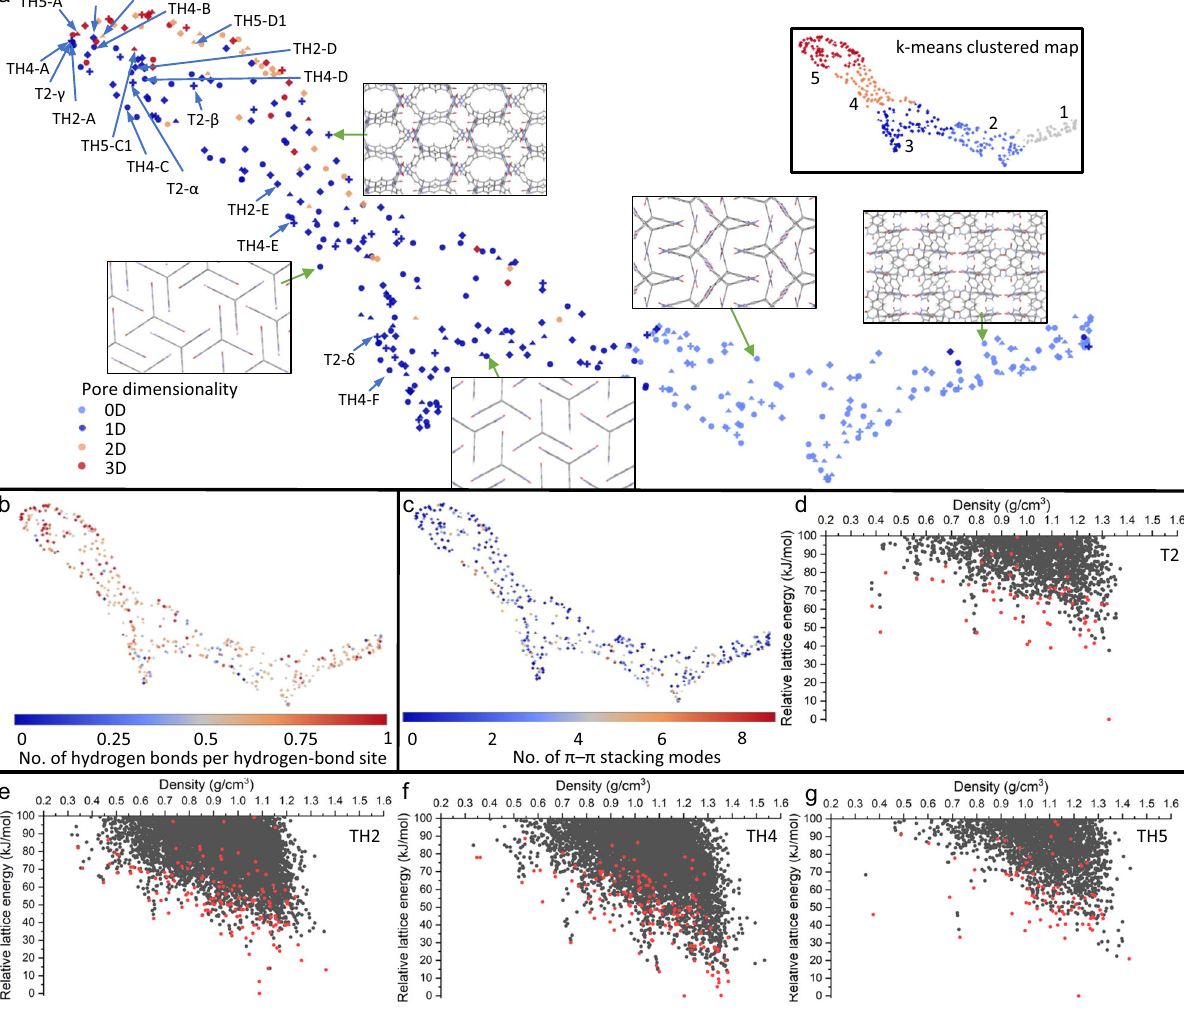
Fig. 5 Porosity space of the landmark structures of TH2, TH4, TH5 and T2. a – c 2D UMAP embeddings of the porosity spaces of TH2 (diamond), TH4 (circle), TH5 (triangle) and T2 (cross), colour coded by the pore dimensionality ( a ), the number (no.) of hydrogen bonds per hydrogen-bond site ( b ), or the total number of π – π stacking modes of the crystal structure ( c ); the symbol size is scaled by the accessible surface area. All the points shown in ( a – c ) are the lowest-energy structures in the respective clusters by af fi nity propagation and are highlighted in red on their corresponding energy – density landscapes: T2 ( d ), TH2 ( e ), TH4 ( f ) and TH5 ( g